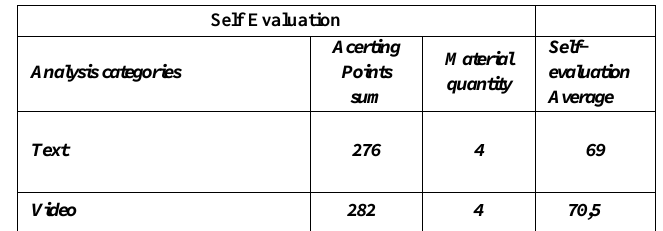
Table 3. Cognitive Residue Analysis by Material Qty